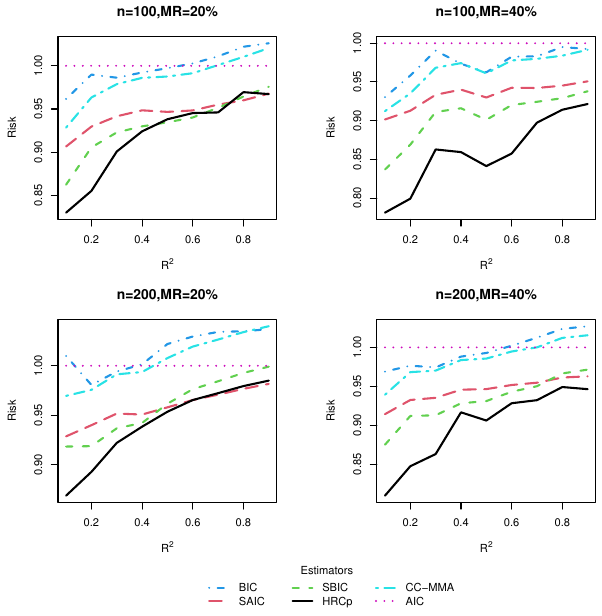
Figure 4. Risk comparisons for Design